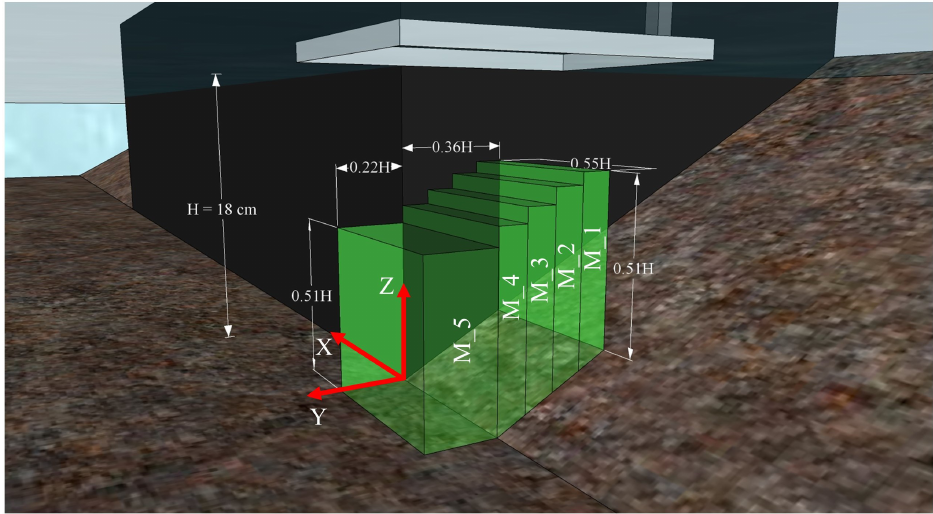
Figure 2. A schematic of the measurement volumes located in the vicinity of the upstream face of the longitudinal